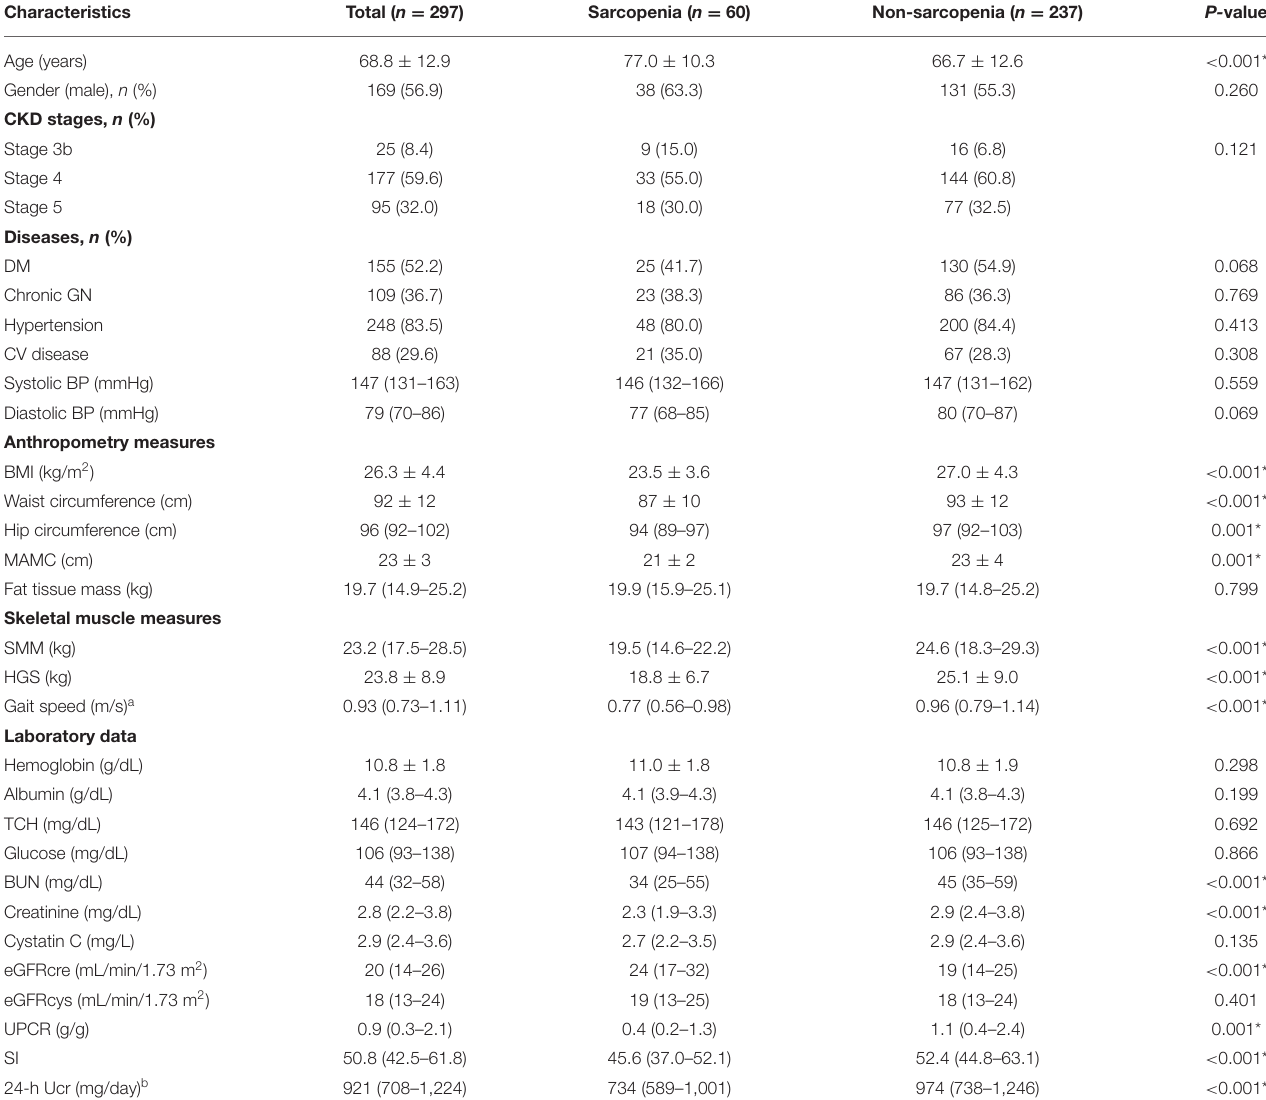
TABLE 1 | Demographic and clinical characteristics of the study population.